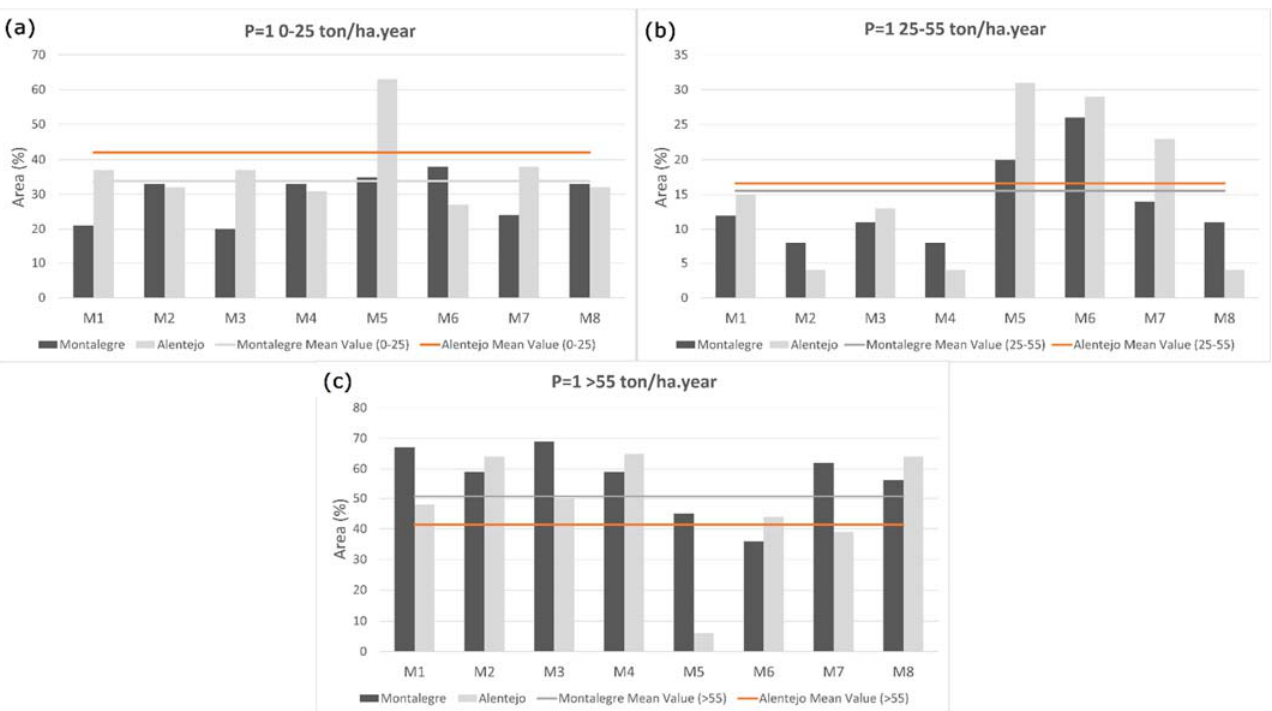
Figure 5. Percentage of area (%) of each region (Montalegre with a total area of 823,230 ha and Alentejo with a total area of 4830 ha) in each class for P = 1: ( a ) 0–25 ton/ha·year; ( b ) 25–55 ton/ha·year; ( c ) >55 ton/ha·year. The lines represent the mean values for each region and within each class. The methodologies are represented as: M1 R w × K w × LS w ; M2 R jrc × K jrc × LS w ; M3 R w × K w × LS m ; M4 R jrc × K jrc × LS m ; M5 R w × K w × LS mw ; M6 R jrc × K jrc × LS mw ; M7 R w × K w × LS mc ; M8 R jrc × K jrc × LS mc .